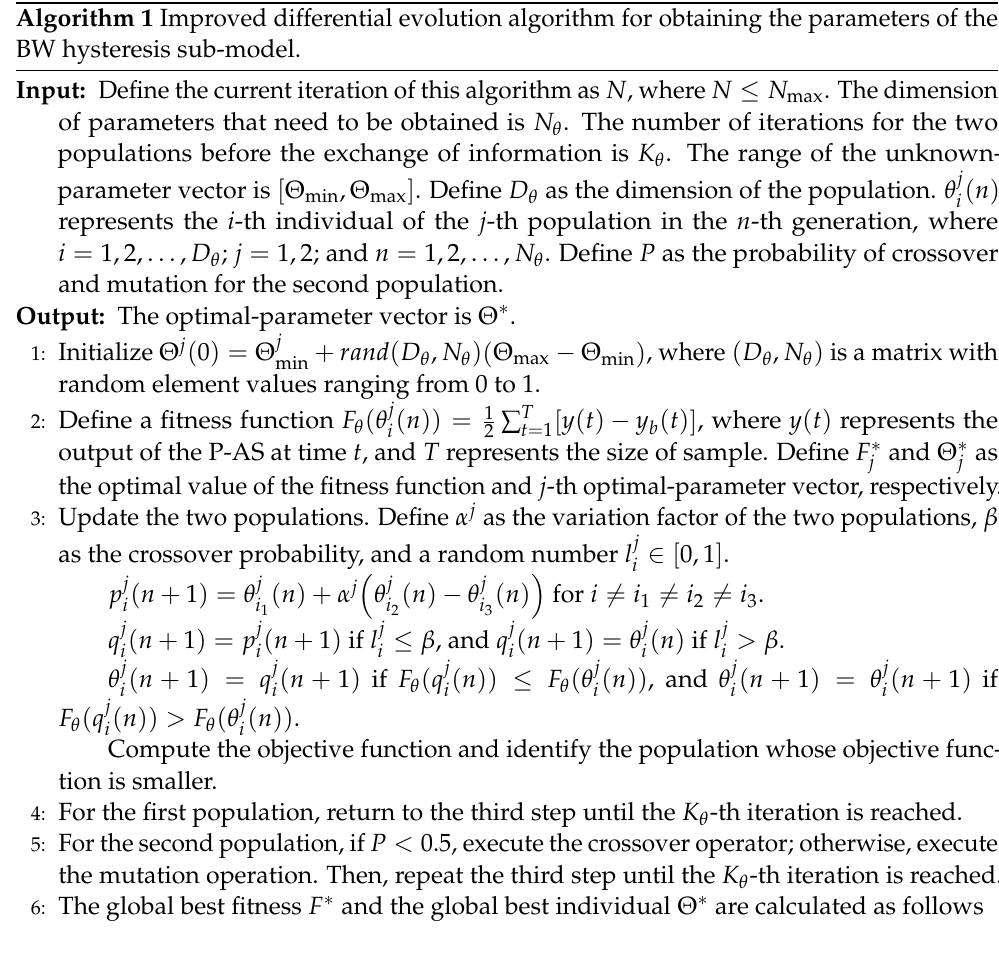
Algorithm 1 Improved differential evolution algorithm for obtaining the parameters of the BW hysteresis